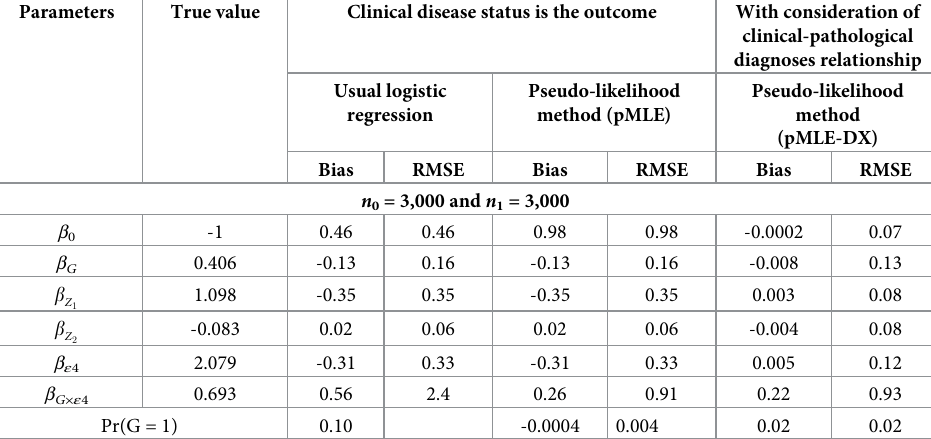
Table 1. Bias and RMSE in parameter estimates when β Parameters True value Clinical disease status is the outcome With consideration of